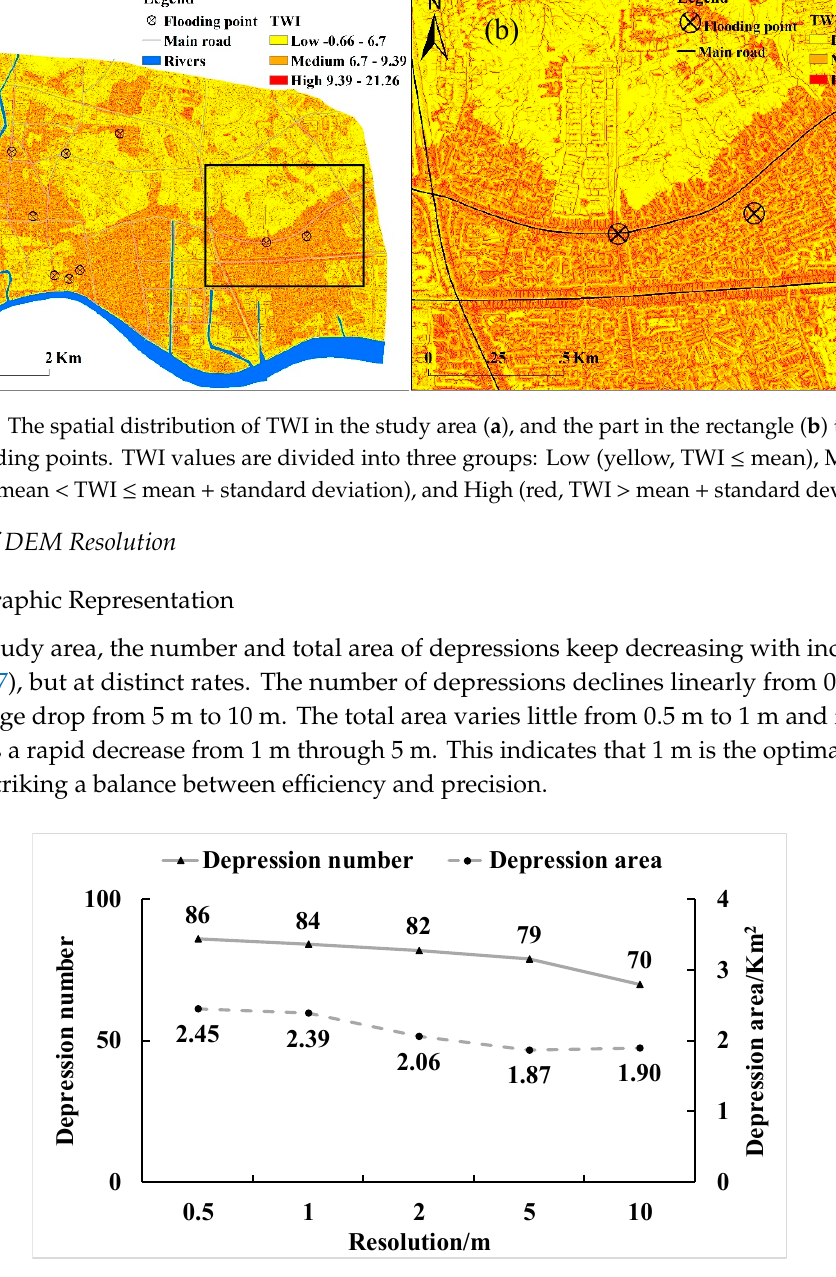
Figure 7. Changes in the number and total area of depressions with increasing DEM cell size.